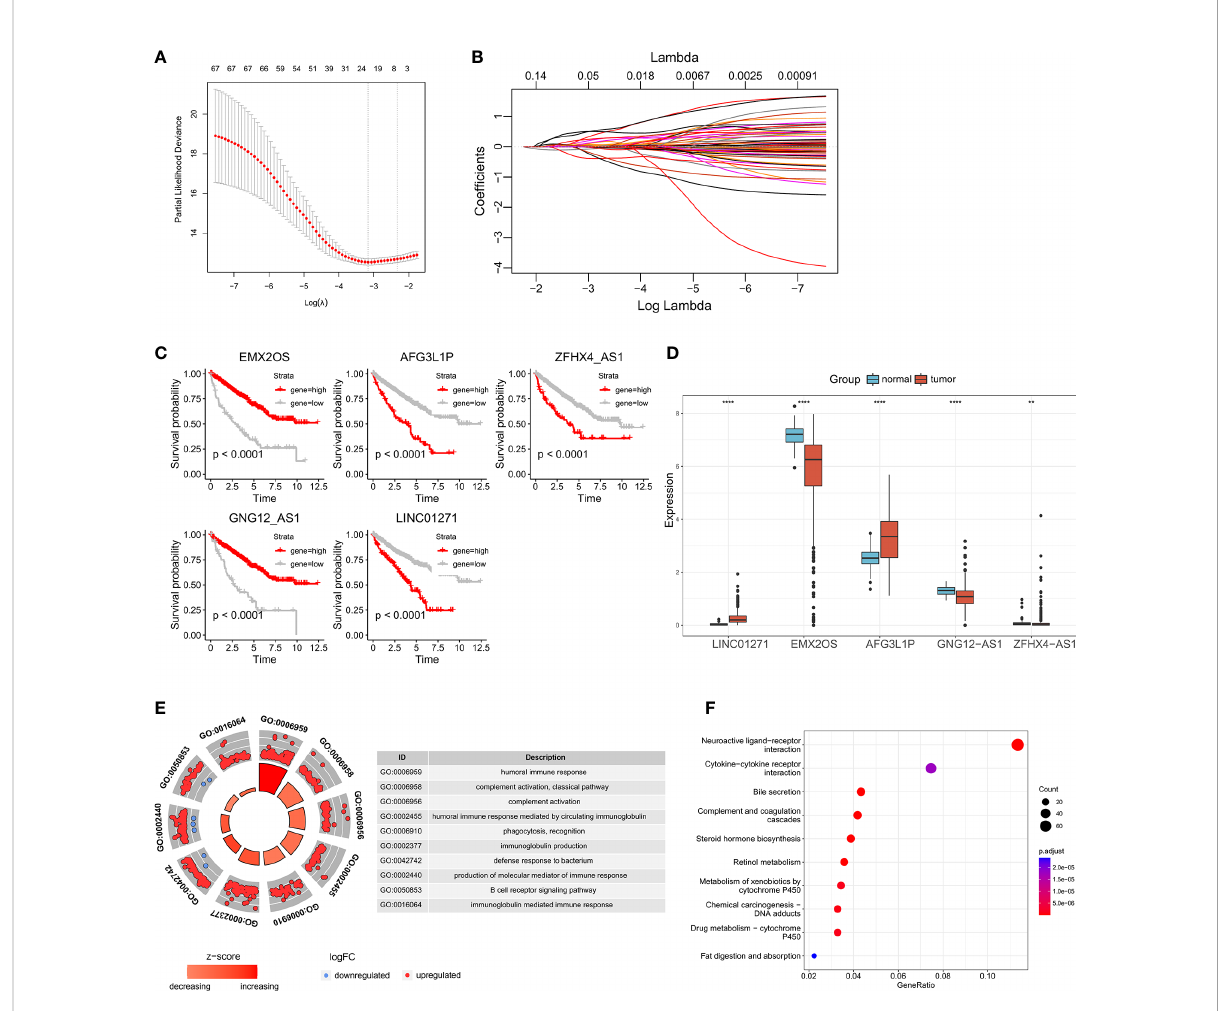
FIGURE 2 Identi fi cation of prognosis-associated eRNAs: (A, B) LASSO regression analysis of the eRNAs correlated with OS in univariate Cox regression analysis. Survival analysis (C) and differential expression analysis (D) of the fi ve eRNAs constructing the predictive signature. (E, F) GO and KEGG analyses between the high- and low-risk groups. (**p < 0.0, ****p < 0.0001).